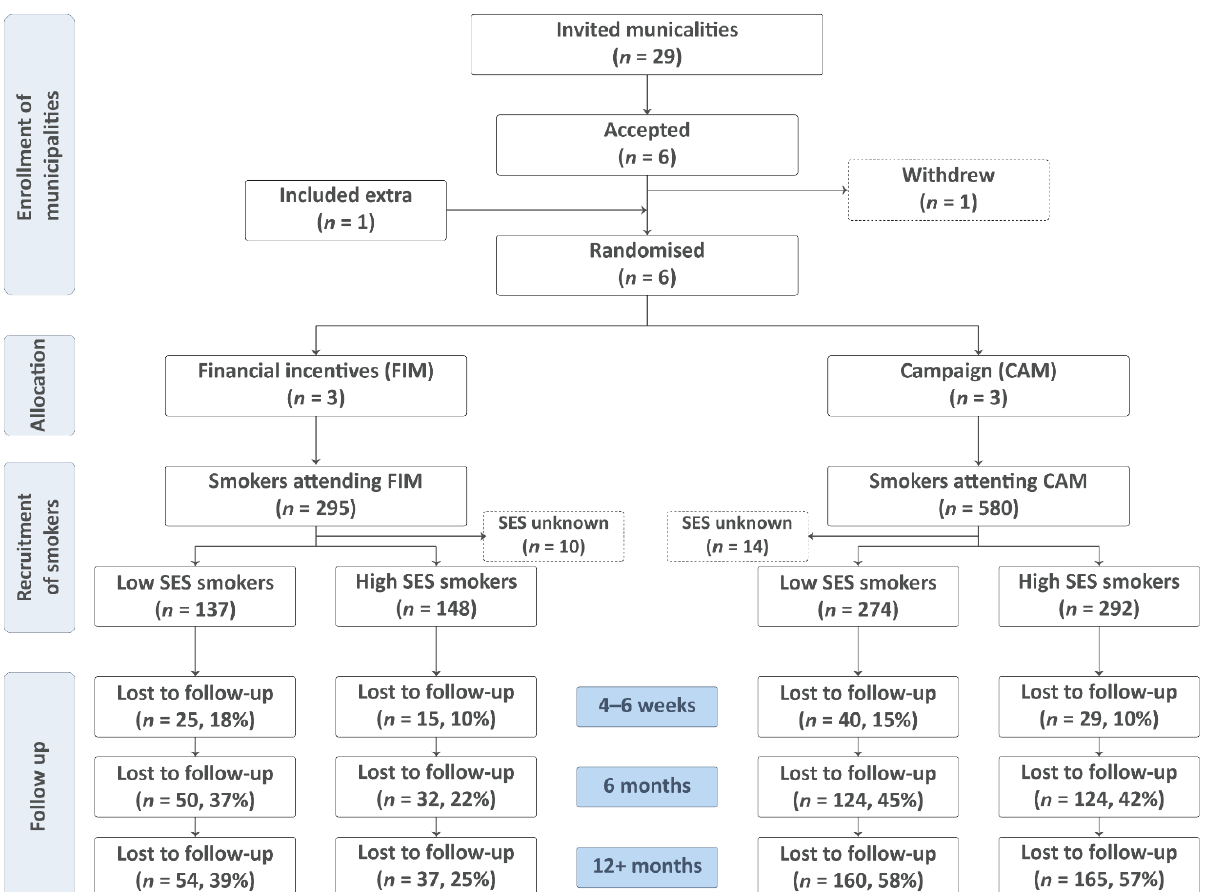
Figure 1. Flowchart of the allocation of municipalities and recruitment and follow-up status of smokers included in the community-randomized trial “Richer without smoking”, Denmark.